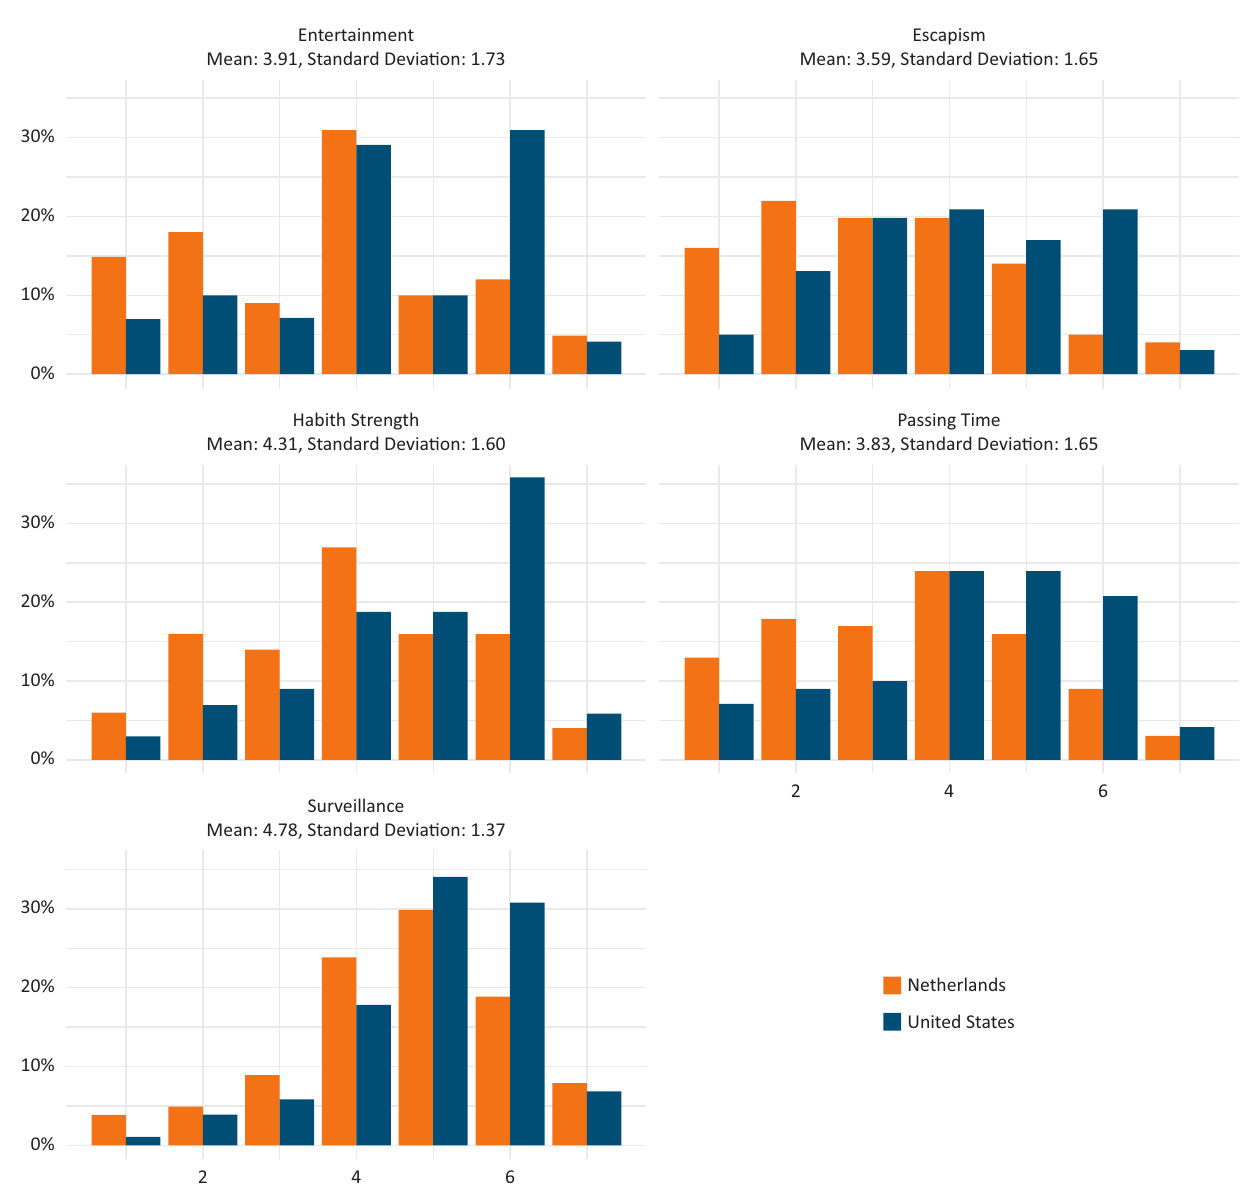
Figure 2. Descriptive information of the independent